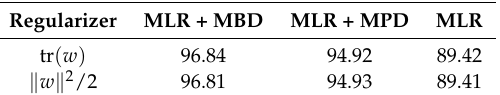
Table 9. MLR regularizer analysis on MLII.